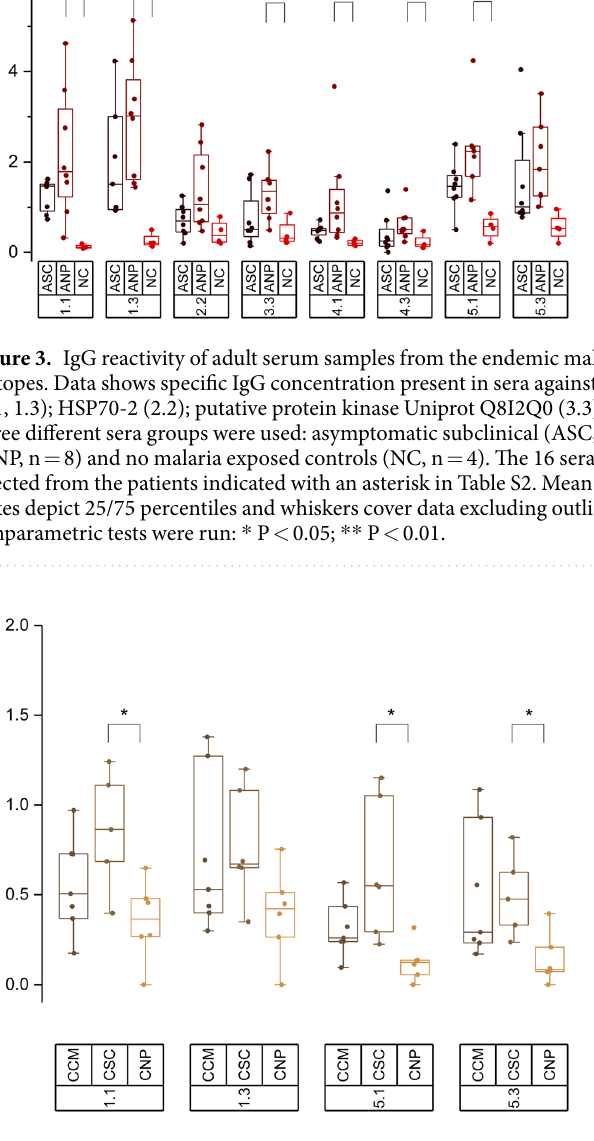
IgGs anti-Plasmepsins I and II, (proteases involved in host hemoglobin digestion) were similarly found in sera from both imported malaria groups. Plasmepsin I has been detected in intraerythrocytic young stages whereas Plasmepsin II expression has been associated with mature stages 44 . A similar distribution was observed in the generation of antibodies against dihydrolipoyl dehydrogenase and dihydrolipoamide acyltransferase, both of them components of the multienzyme pyruvate dehydrogenase complex. Two further metabolism-related pro- teins from the parasite, ferrodoxin reductase-like protein, involved in fatty acid metabolism, and vacuolar ATP synthase subunit b, likely involved in acidification of the digestive vacuole 45 , raised antibodies against them in sera from both groups. However, while antibodies against ferrodoxin-reductase-like protein were found mainly in patients with clinical symptoms, the vacuolar ATP synthase subunit b was more antigenic in those individuals without clinical signs of malaria. The most frequently detected antigen was initially identified as a conserved protein of unknown function Uniprot Q8I2Q0, corresponding to gene PF 3D7_0925900 in the genome of P. falciparum 3D7. Further analysis by sequence comparison (not shown) revealed that this sequence may corre- spond to an uncomplete gene duplication of a putative protein kinase Uniprot Q8I2P9, corresponding to gene